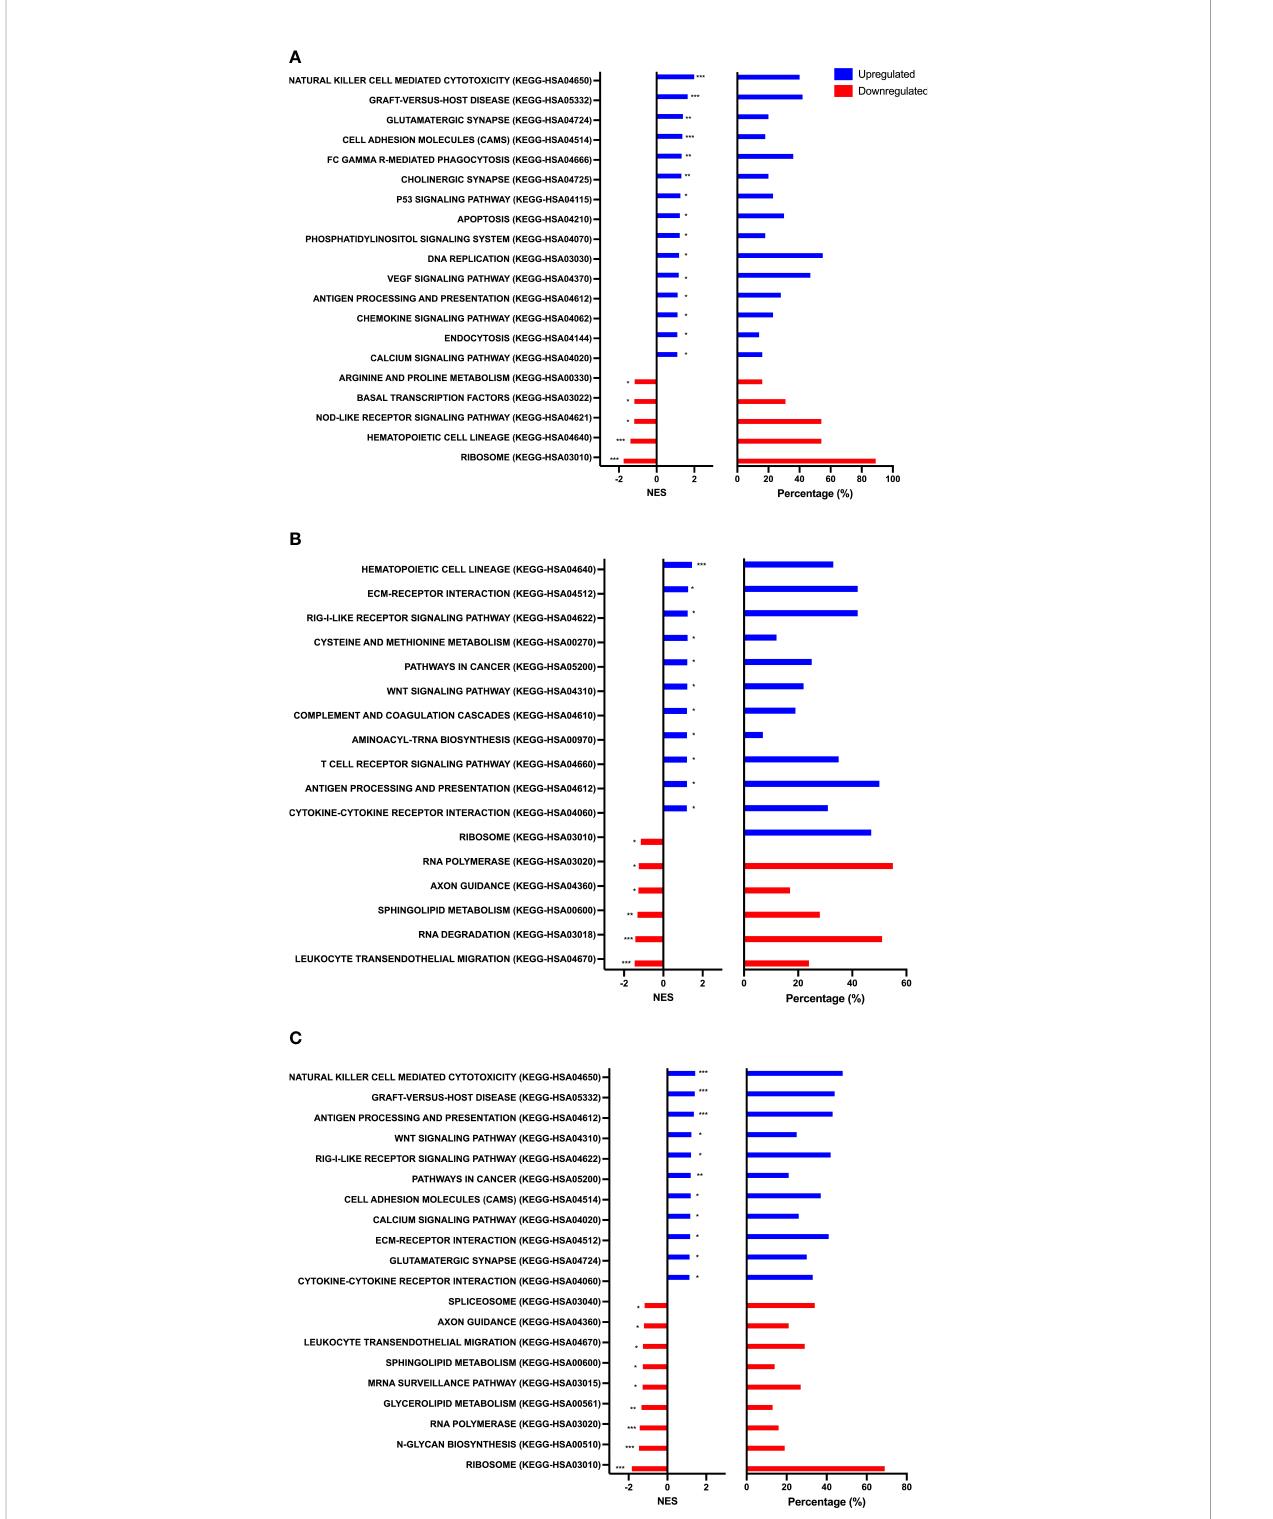
FIGURE 4 Gene set enrichment analysis performed using KEGG terms. Graphs show enriched upregulated (blue) and downregulated (red) pathways as well as the percentage of DEGs contributing to each mechanism between (A) Rest vs 80% (B) 80% vs . +1H, and (C) Rest vs +1H.Signi fi cance is indicated by * ( p < 0.25), ** ( p < 0.10), *** ( p <